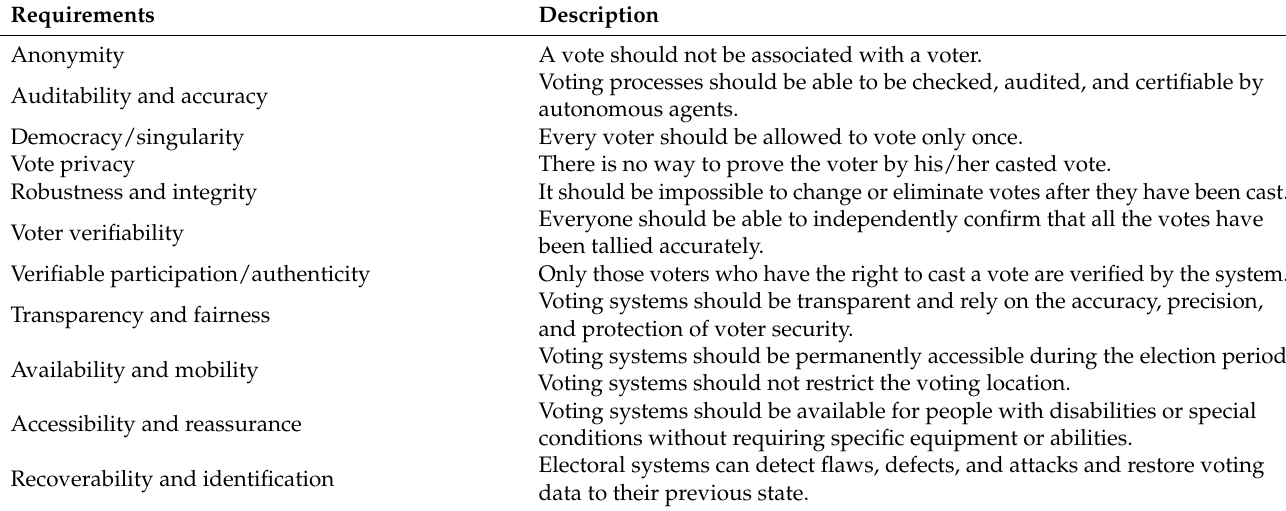
Table 1. Electronic voting system